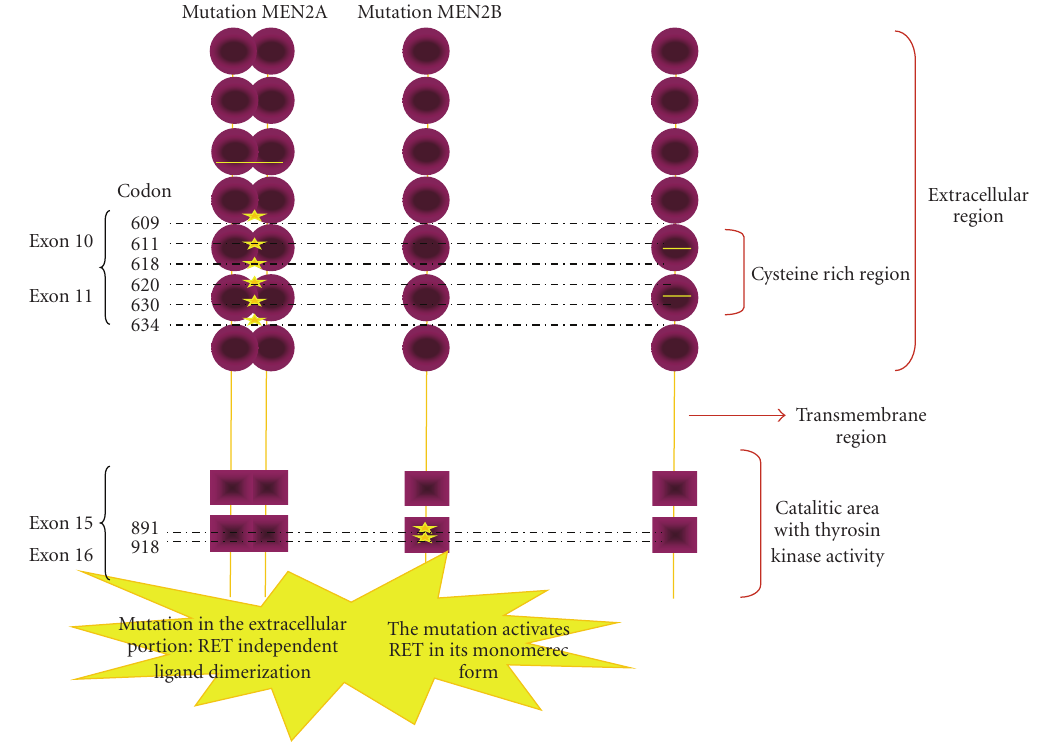
Figure 1: RET mutations in medullary thyroid